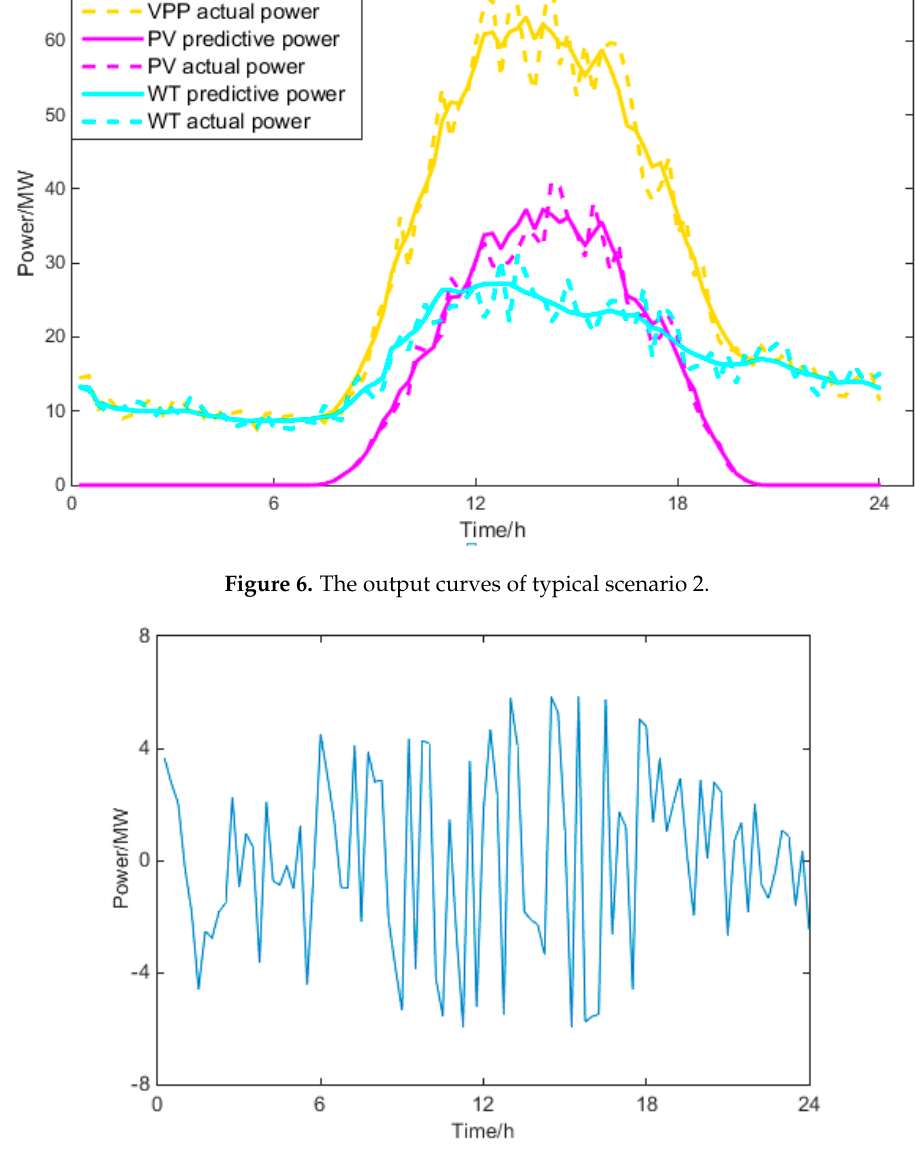
Figure 7. The output curve of energy storage resources of typical scenario 2.